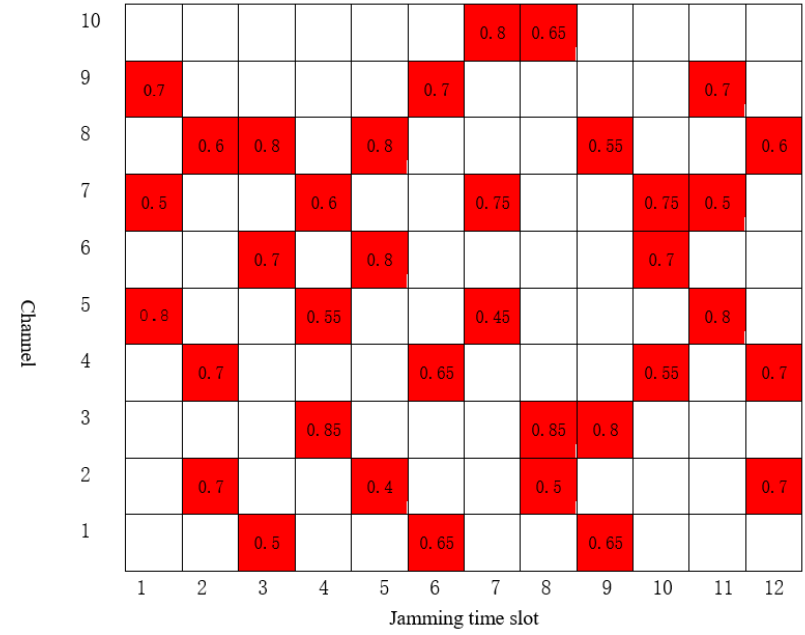
Figure 6. Probability distribution of intelligent blocking